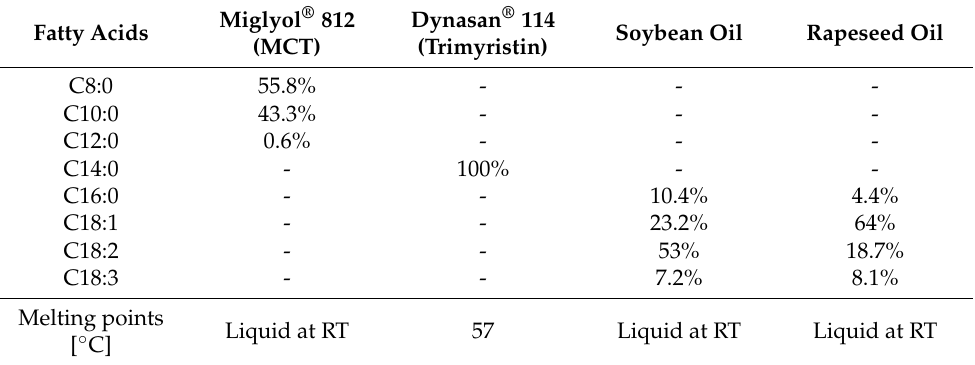
Table 5. Oil composition according to the manufacturer’s certificate of analysis [38–41] and melting point of trimyristin